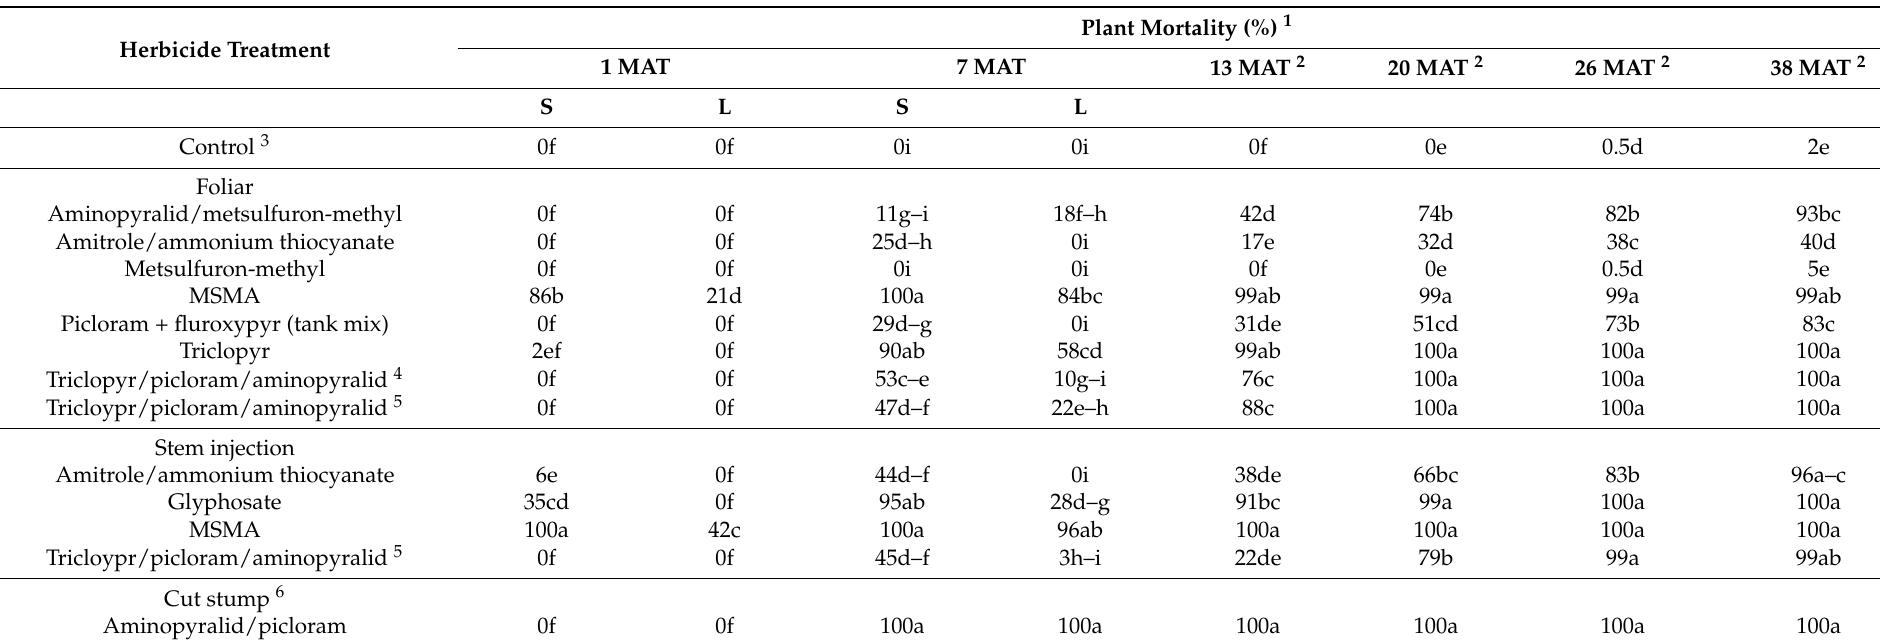
Table 4. Mortality of small (S) and large (L) C. uruguayanus plants 1, 7, 13, 20, 26 and 38 months after treatment (MAT) in response to herbicide treatments applied in October 2016 (Experiment